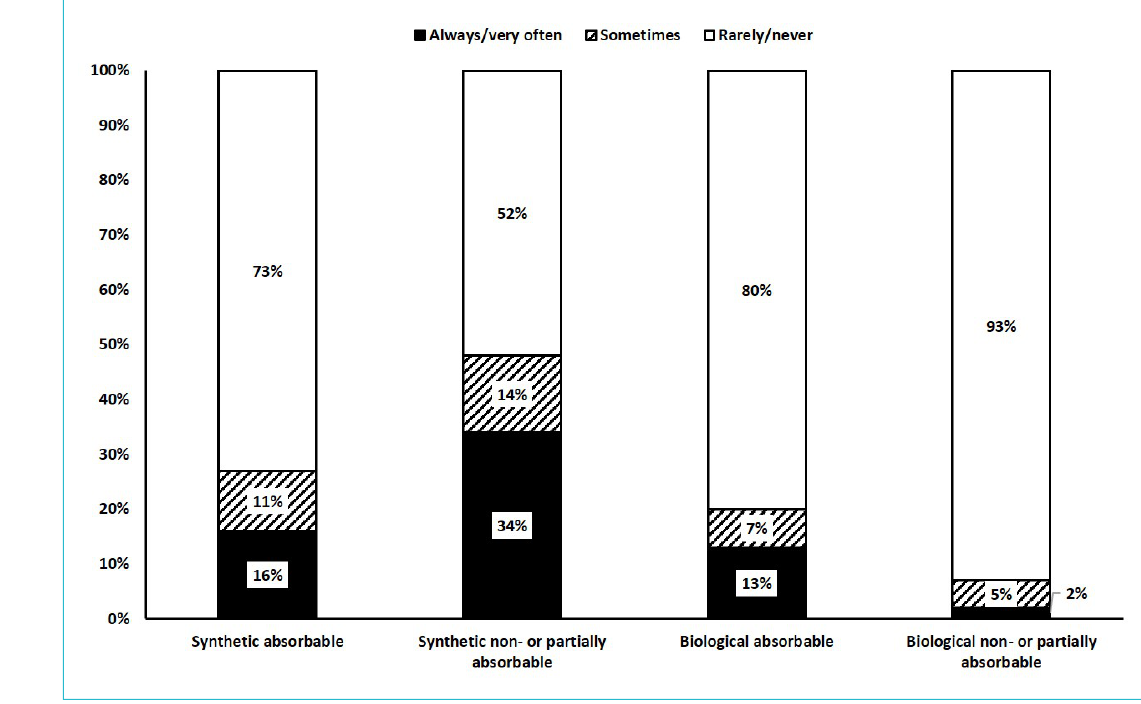
Figure 2: Mesh types used in type III hiatal hernia repair (% of